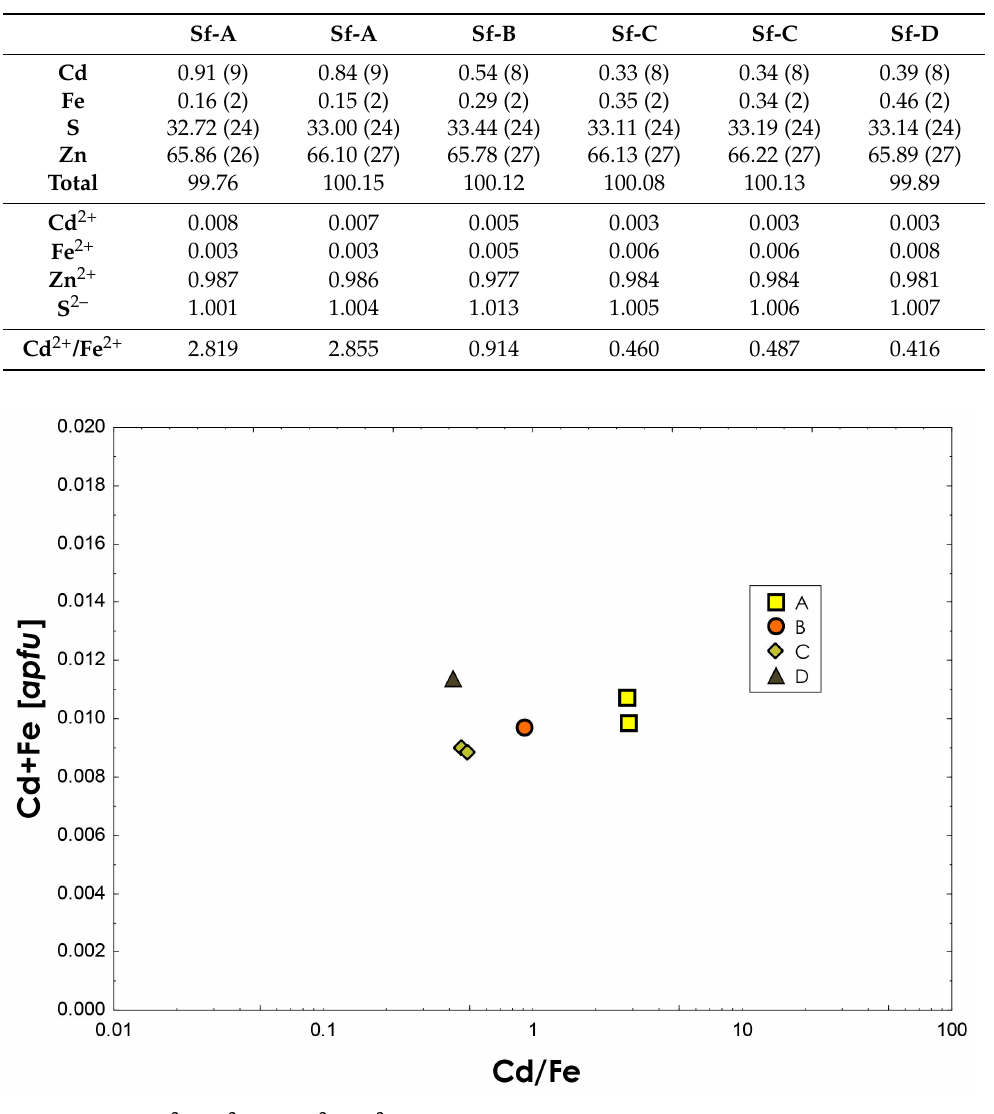
Figure 3. The Cd 2+ /Fe 2+ vs. Cd 2+ +Fe 2+ plot with data from EMPA analyses of each sample. Table 2. LA-ICP-MS analyses of studied sphalerite; d.l—detection